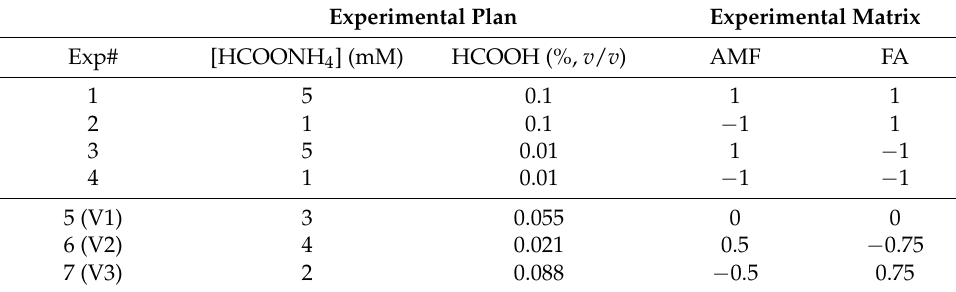
Table 1. Experimental plan and experimental matrix of the design. Experimental Plan Experimental Matrix